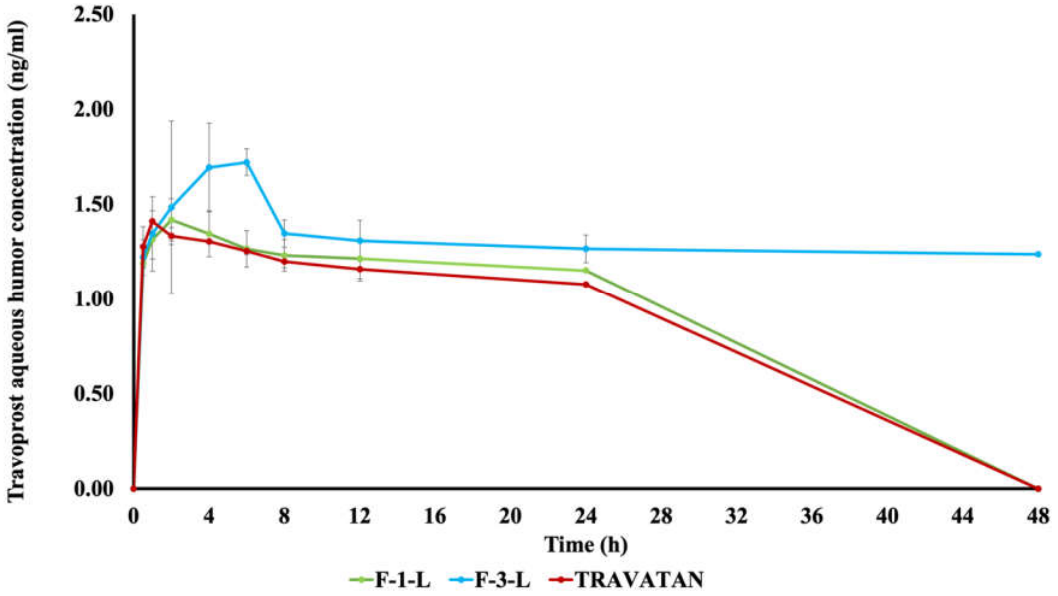
Figure 7. Aqueous humor TRAVO concentrations versus time post-application of F-1-L, F-3-L, and Travatan ® in the rabbits’ left eyes (mean ± S.D, n = 3).